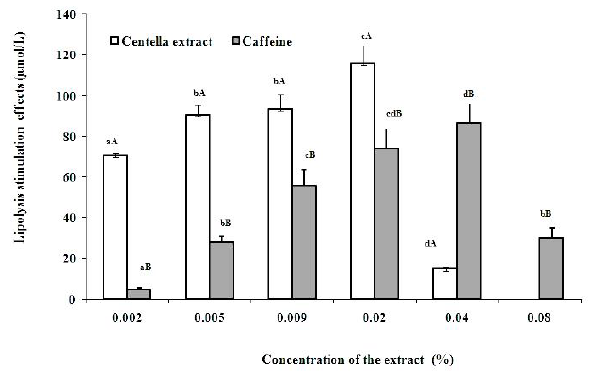
(a-d): Values with di ff erent letters are signi fi cantly di ff erent at P < 0.05 for the same source of extract; (A-B): Values with different letters are significantly different at P < 0.05 for each concentration of the